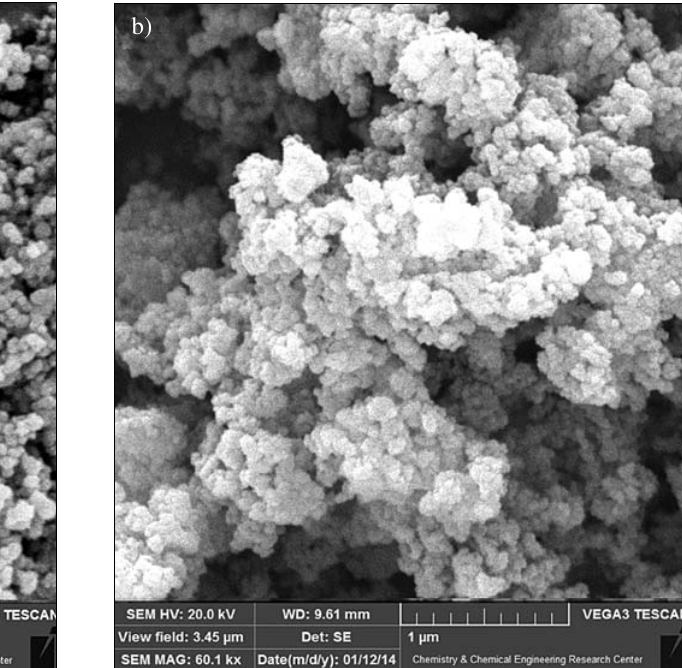
Figure 3. The SEM images of Fe